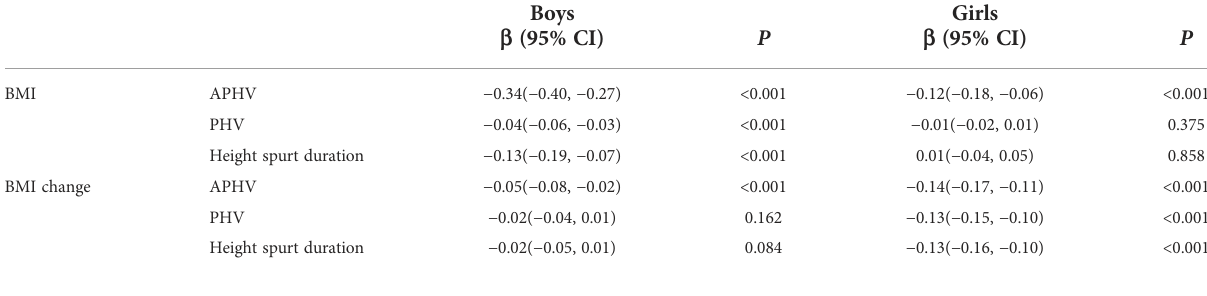
TABLE 2 The association between characteristics of height growth patterns and body mass index (BMI) in late